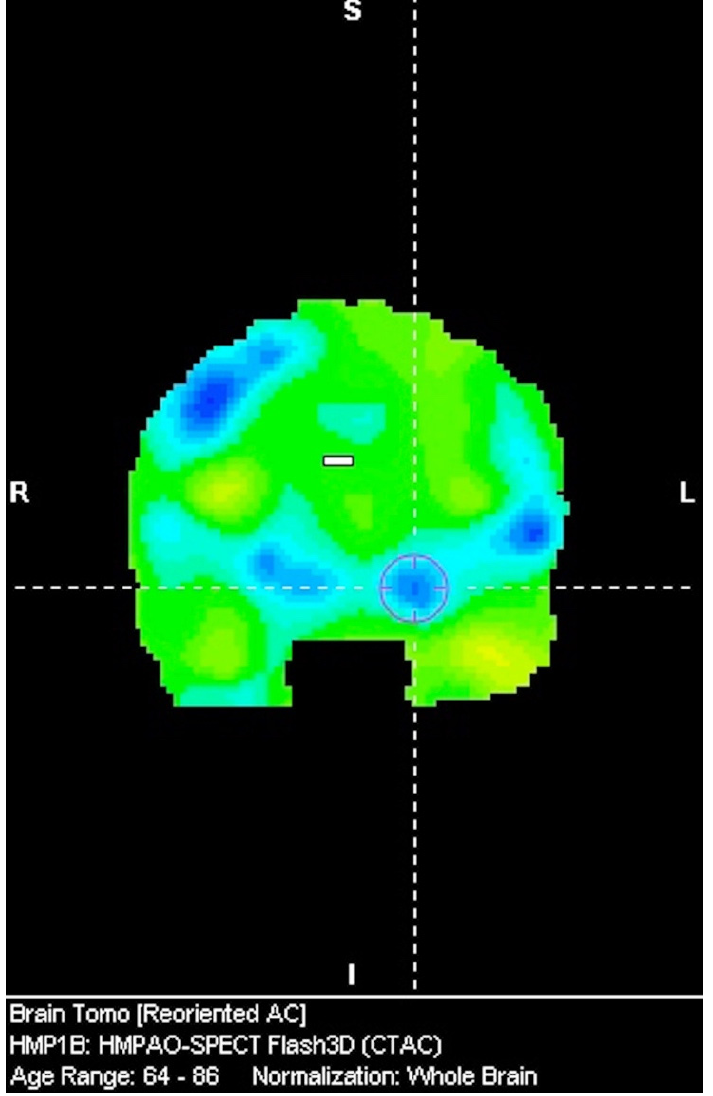
Figure 2. Hypoperfusion of the amygdala in CBS.